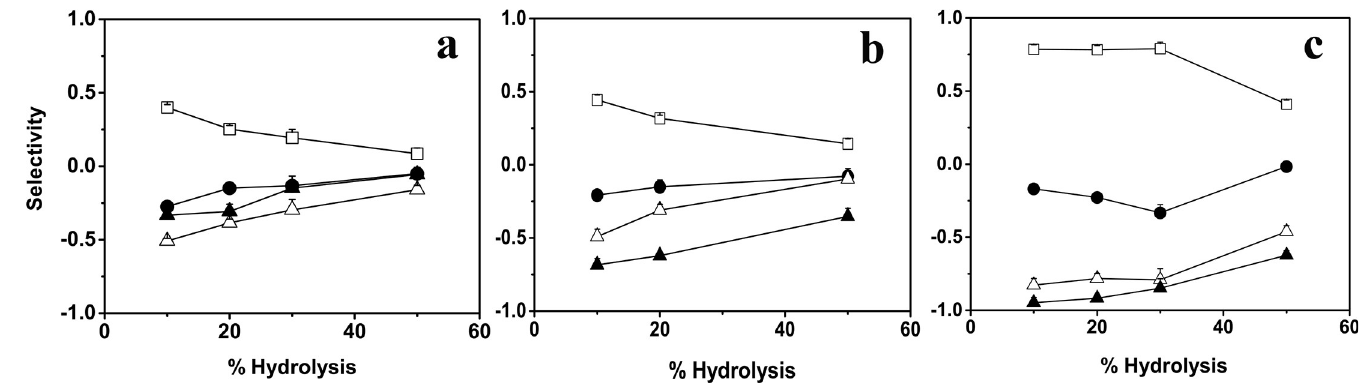
Fig 6. Fatty acid selectivity of GTL and mutants. Fatty acid selectivity of (a) GTL, (b) CM-GTL and (c) DM-GTL at various extents of hydrolysis of anchovy oil. Saturated fatty acids (Open square), mono-unsaturated (Dark circle), EPA (Open triangle) and DHA (Dark Triangle). Selectivity value 0 indicates neutral hydrolysis, 1 indicates total preference and -1 indicates total discrimination (no